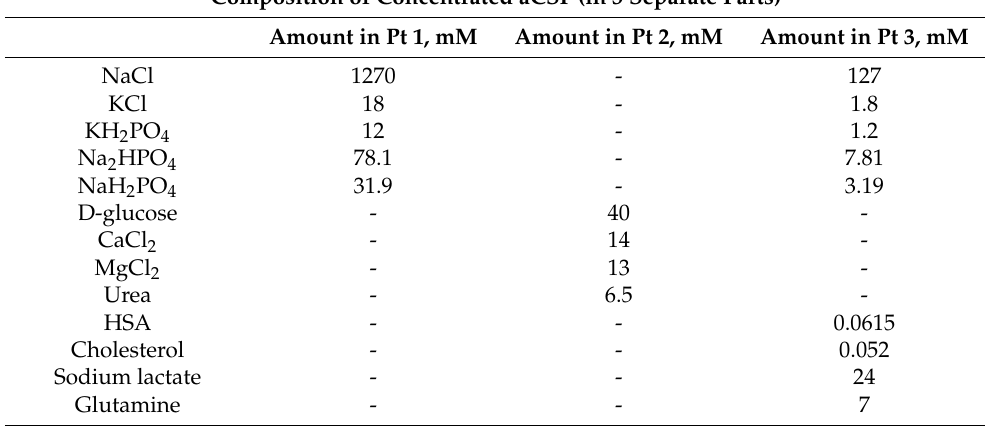
Table 1. Composition of 10 ×